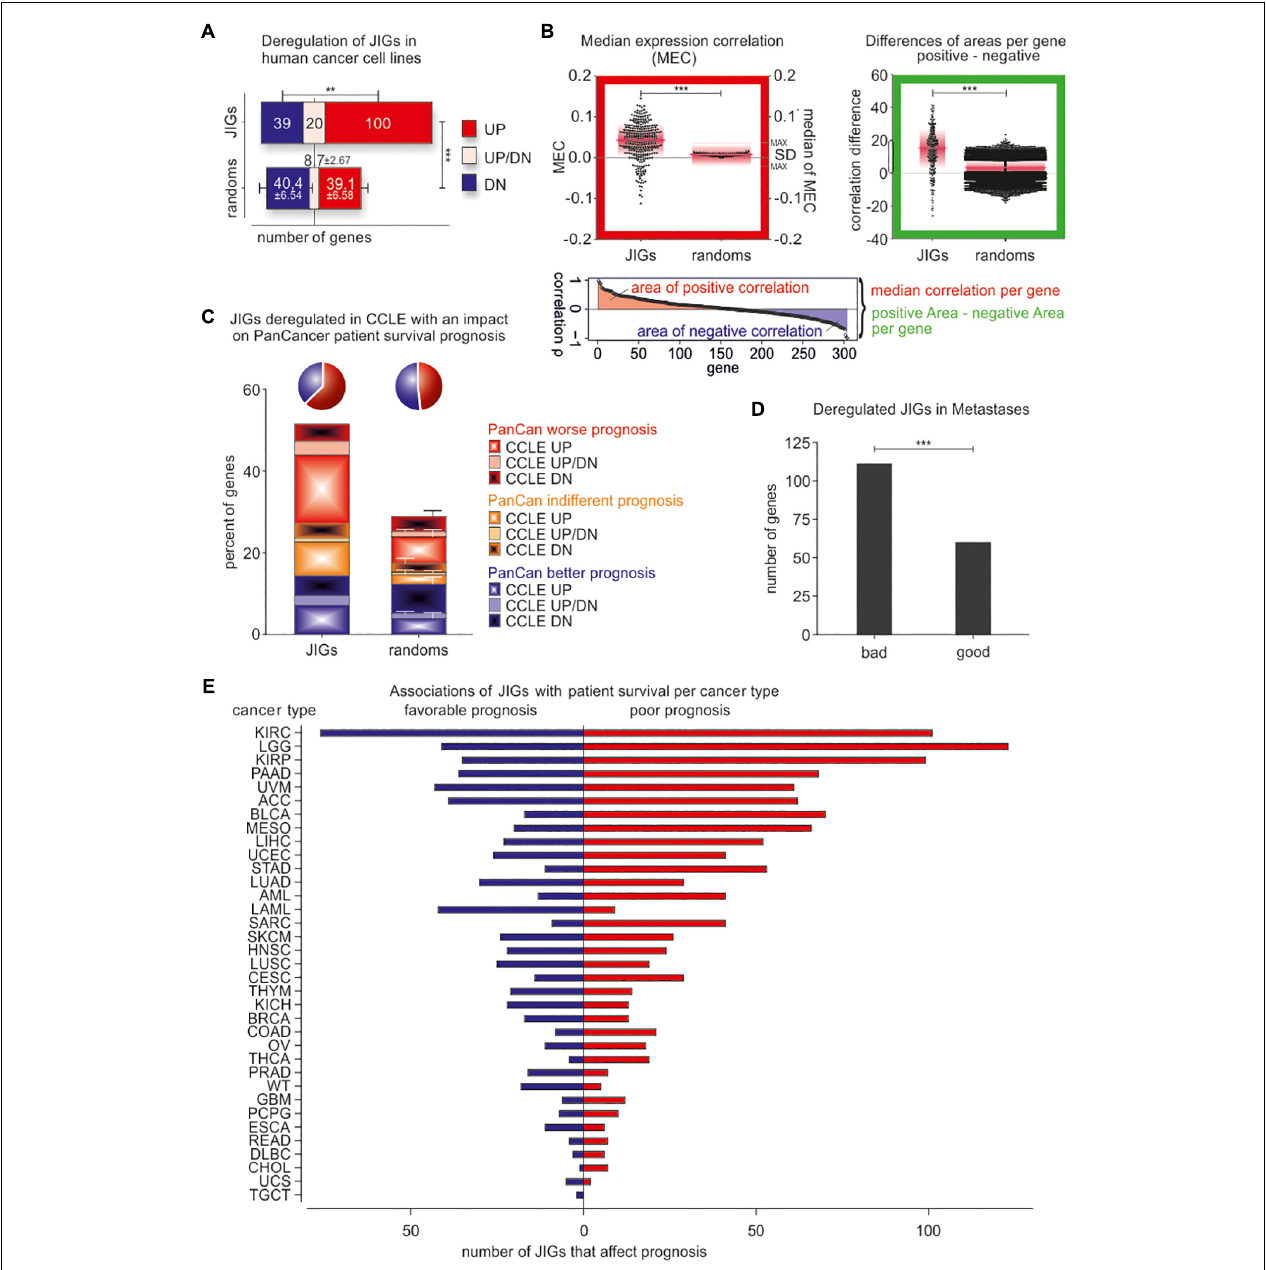
FIGURE 5 | JIGs are transcriptionally deregulated in invasive/metastatic stages and predict clinical outcomes in a cancer type-dependent manner. (A) JIG transcripts are deregulated in the highly invasive versus the less-invasive CCLE cell lines, and the total percentage is 1.8-fold higher than the corresponding percentage of control lists. Red: upregulated, blue: downregulated, pink: cancer type-dependent deregulation. Error bars represent mean with SD. (B) Red-boxed diagram: median expression correlation (MEC) in PanCan and SD of MEC (pink boxes) are higher among JIGs compared to random lists (shown are the 100 medians of MEC with maximal SD). Green-boxed diagram: the differences of positive versus negative area of correlation per gene show (a) a significantly larger span and (b) over all a higher positive value compared to 100 random gene lists. Pink lines represent the median, pink boxes represent SD. (C) Cox regression analysis of JIGs on the survival of the TCGA PanCan cohort. 227 JIGs correlated with patient outcomes, of which 141 predicted worse and 86 better outcomes. Among 159 deregulated JIGs in highly-aggressive states across several cancer types of CCLE, 118 JIGs (74.2%) influence patient prognosis. Of those, 74 (62.7%) (pie chart, blue) had an adverse effect, 51 were exclusively upregulated in aggressive states of CCLE (CCLE UP, plain red), while additional 10 JIGs were upregulated in some as well as downregulated in other cancer types (CCLE UP/DN, plain pink). Only 44 JIGs differentially expressed in CCLE (dashed blue, plain blue, and dashed pink) had a beneficial effect on survival prognosis (pie chart, green). (D) Transcriptional deregulation of JIGs in metastases versus primary tumor or normal tissue, and correlation with JIGs that affect patient prognosis in PanCan. JIG deregulations in 6 metastatic cancer types are more correlated with poor outcomes (1.85:1). (E) Survival analysis for JIGs across different TCGA cancers. The prognostic potential of JIGs depends on the cancer type. In the majority of cancer types, more JIGs are associated with poor prognosis and less with favorable prognosis. No cancer tissue was found unaffected by JIGs.